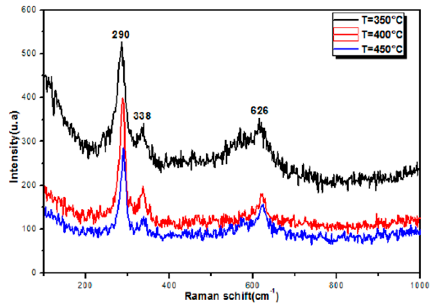
Figure 2. Raman spectra of CuO thin films deposited at 350 °C, 400 °C and 450